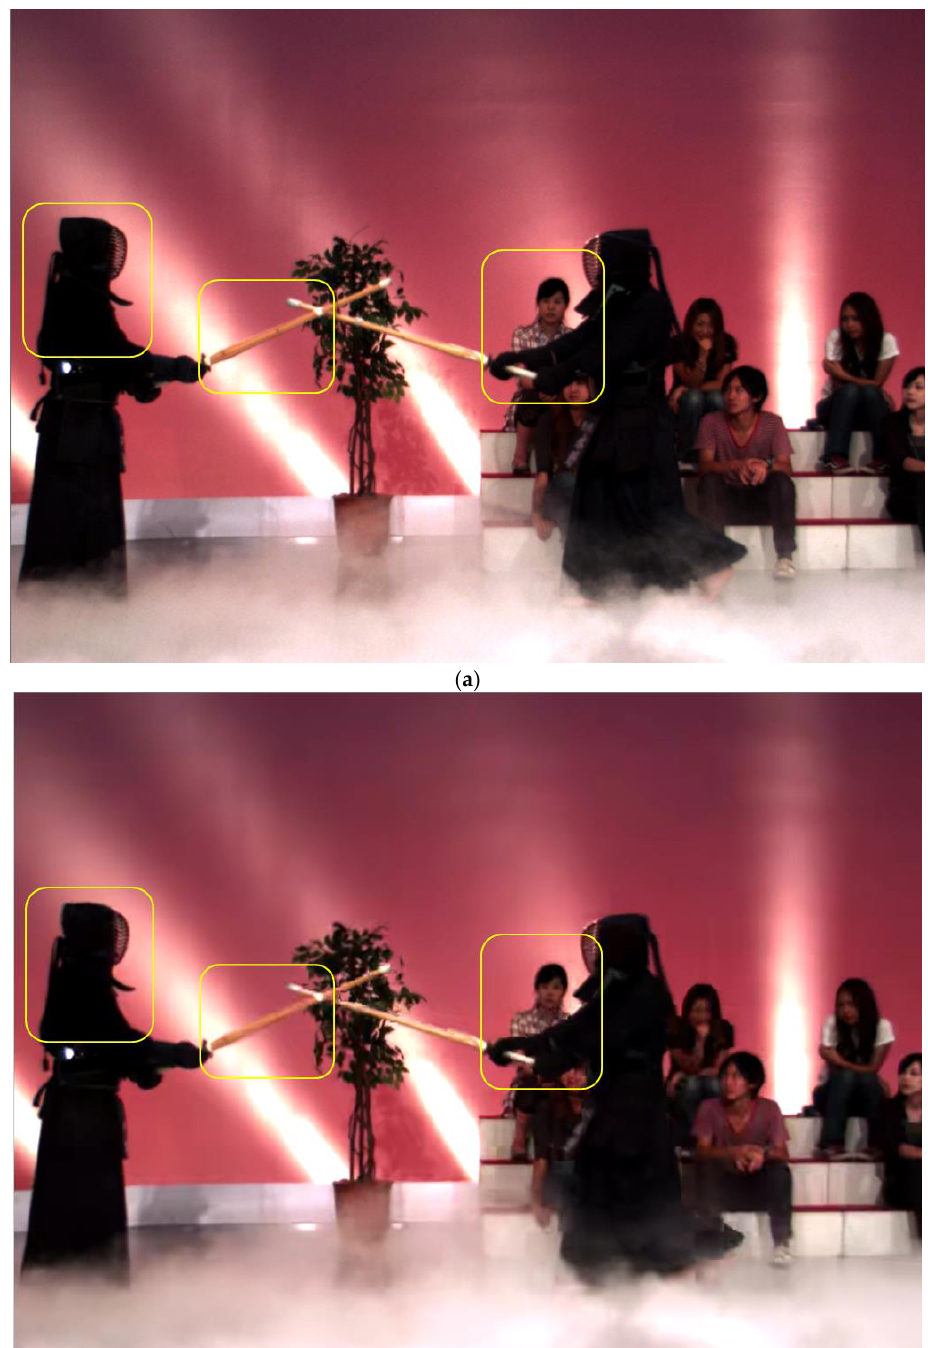
Figure 7. Decoded frame number 16 from Kendo videos of ( a ) the proposed codec and ( b ) the MV-HEVC standard codec.